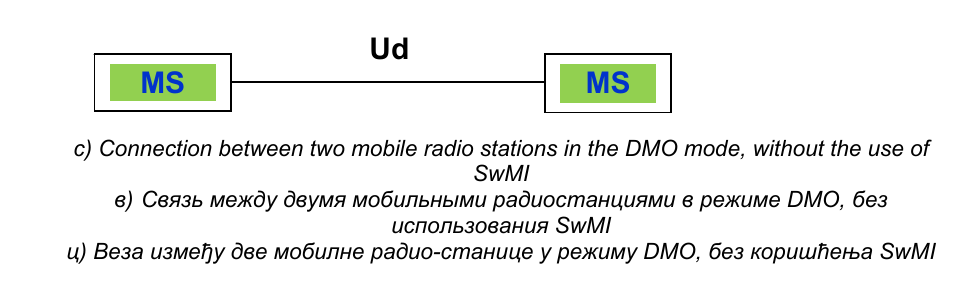
Figure 11 – Overview of the variants of the standard configurations of TETRA 1 mobile radio networks (ETSI,